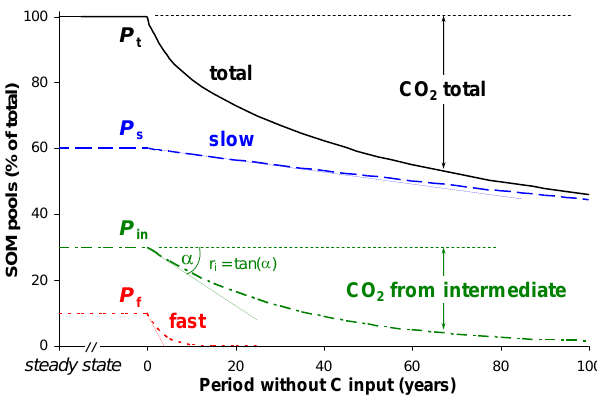
Fig. 1. Decrease of C pools in a soil by long-term bare fallow (LFTB) experiments. The decrease of three pools with fast ( P f ), intermediate ( P in ) and slow ( P s ) decomposition rates and the re- spective amounts of CO 2 associated with these pools (for clarity it is shown only for intermediate pool and total C in soil) are pre- sented. The decomposition is accepted by first order kinetics, and P corresponds to the pool size at steady state (before the start of long-term bare fallow), where the decomposition rates ( r ) are equal to the tangent of the angle α ( r = tan (α) ). Explanations in